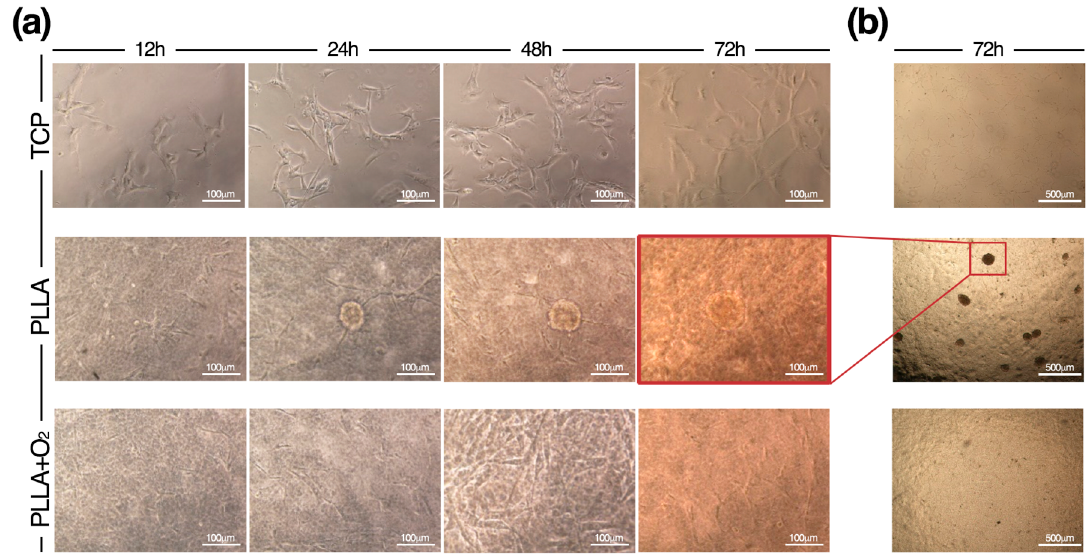
Figure 6. Time-to-time formation of hASC spheroids on PLLA. ( a ) Representative brightfield images by an Eclipse-TS100 microscope equipped with a Nikon camera (Nikon, Tokyo, Japan), show the spheroids’ organization of hASCs during the culture period on PLLA films and their canonical fibroblasts-like morphology on PLLA+O 2 film and on TCP; and ( b ) representative overview of hASCs on TCP, on PLLA, and on PLLA+O 2 films.